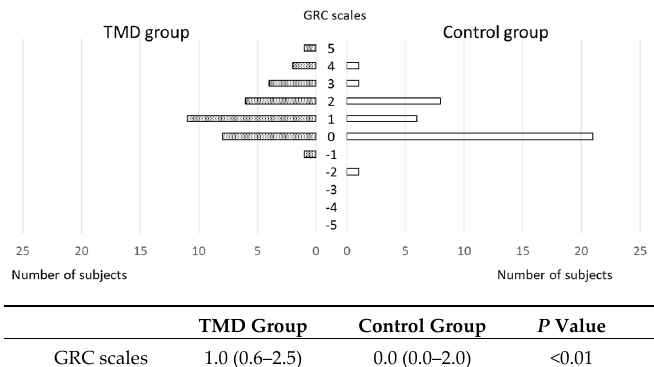
Figure 4. Maximum bite forces before and after transcutaneous electrical nerve stimulation (TENS) application. Data are the mean ± standard deviation. The solid line indicates the temporomandibular disorder (TMD) group, and the dotted line indicates the control group. There were significant differences in maximum bite force between TMD and control groups ( p < 0.001) and between before and after TENS application ( p < 0.01) as a univariate test (General linear model analysis).